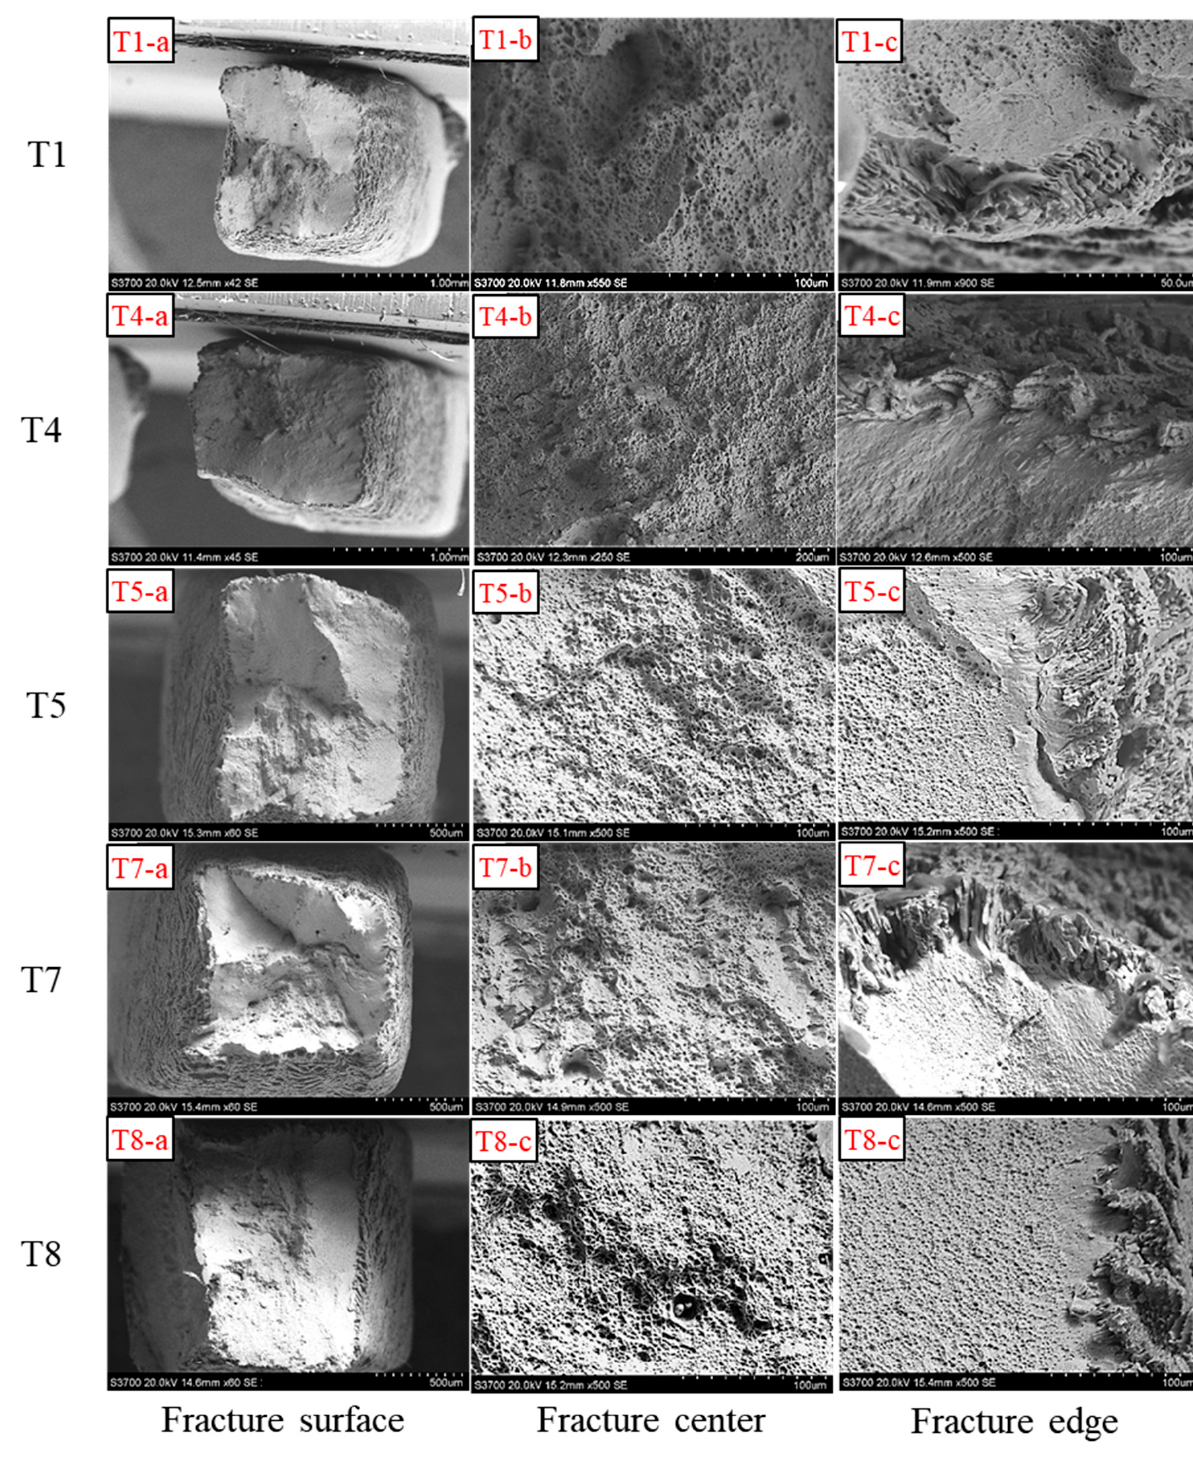
Figure 9. Macroscopic fracture surfaces of the TIG welds after hydrogen charging ( T1-a is fracture surface of T1, T1-b is fracture center of T1, T1-c is fracture edge of T1; T4-a is fracture surface of T4, T4-b is fracture center of T4, T4-c is fracture edge of T4; T5-a is fracture surface of T5, T5-b is fracture center of T5, T5-c is fracture edge of T5; T7-a is fracture surface of T7, T7-b is fracture center of T7, edge of